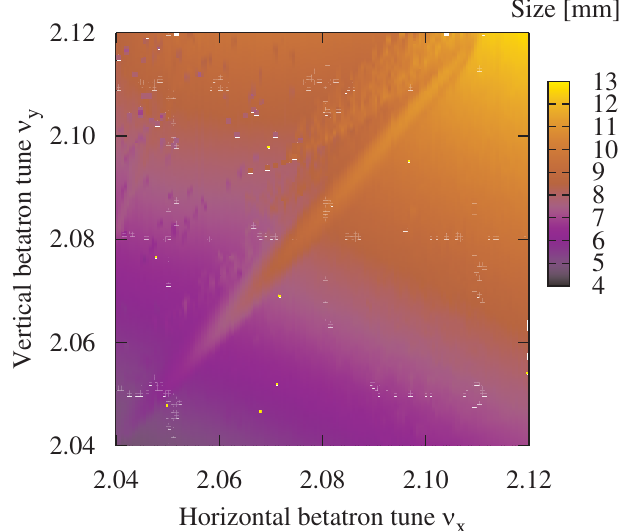
FIG. 5. (Color) Betatron tune dependence of on-momentum dynamic aperture of S-LSR, at the center of the deflector. The horizontal and the vertical axis are the horizontal and vertical linear tune. The color indicates the size of the dynamic aperture. The initial condition of the particles is x (cid:3) y , the other canonical variables are 0. In this distribution map, the maximum value of p , which the particle can circulate during 3000 turns is 2 (cid:1)(cid:1)(cid:1)(cid:1)(cid:1) xy plotted at each operating point. In this tracking, individual error of the lattice element has not been considered; namely, the superperiodicity of the ring is completely 6.